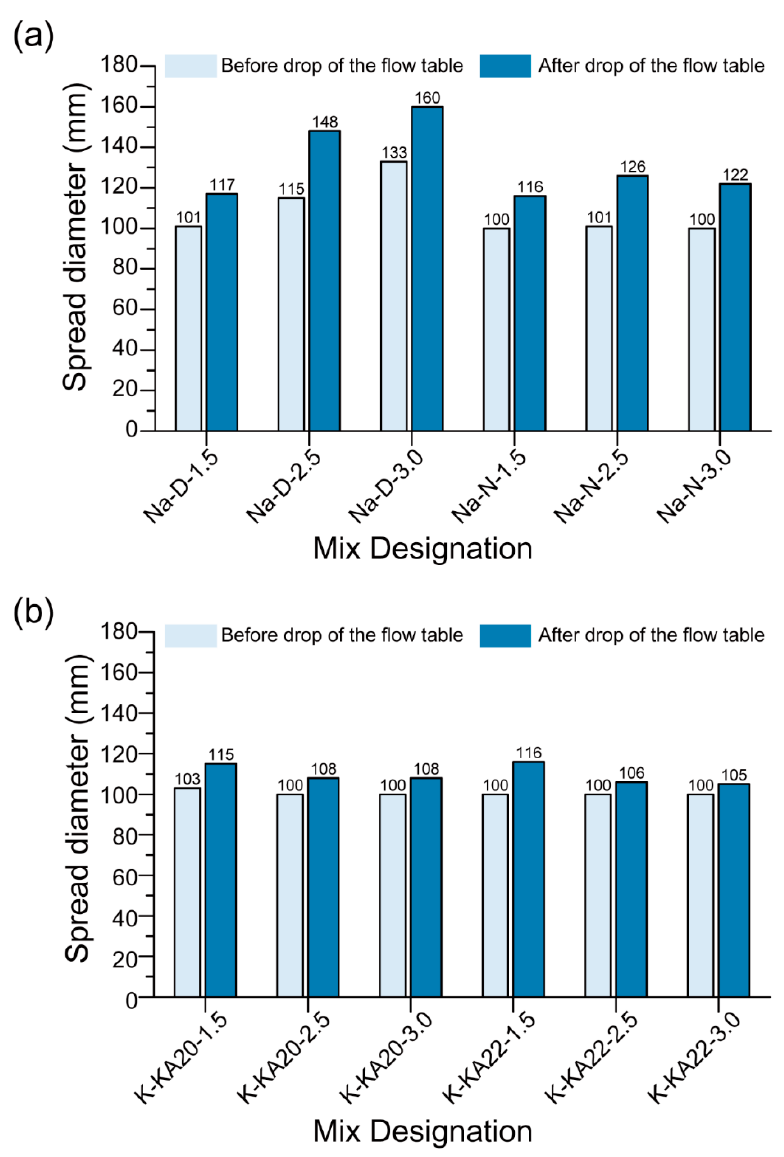
Figure 8. Workability test results of the 3D printable geopolymers with ( a ) Na-based activators and ( b ) K-based activators.